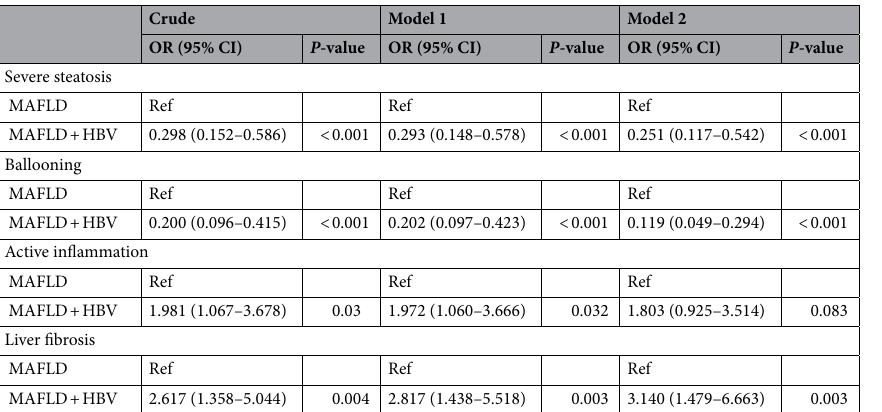
Table 2. Odds ratio of hepatitis B virus infection for liver fibrosis in metabolic dysfunction-associated fatty liver disease population. Model 1 adjusted for age and sex; Model 2 was adjusted for model 1 plus BMI, hypertension, type 2 diabetes mellitus, hypertriglyceridemia, hypercholesterolemia, hyperuricemia, high LDL- c, and low HDL-c. MAFLD metabolic dysfunction-associated fatty liver disease, HBV hepatitis B virus, OR odds ratio, CI confidence